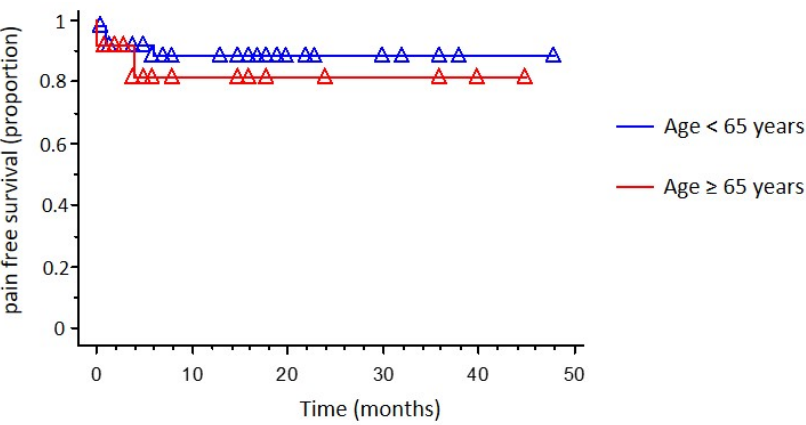
Figure 1. Kaplan–Meier cumulative probability of pain-free survival in patients submitted to MVD, stratified by age.